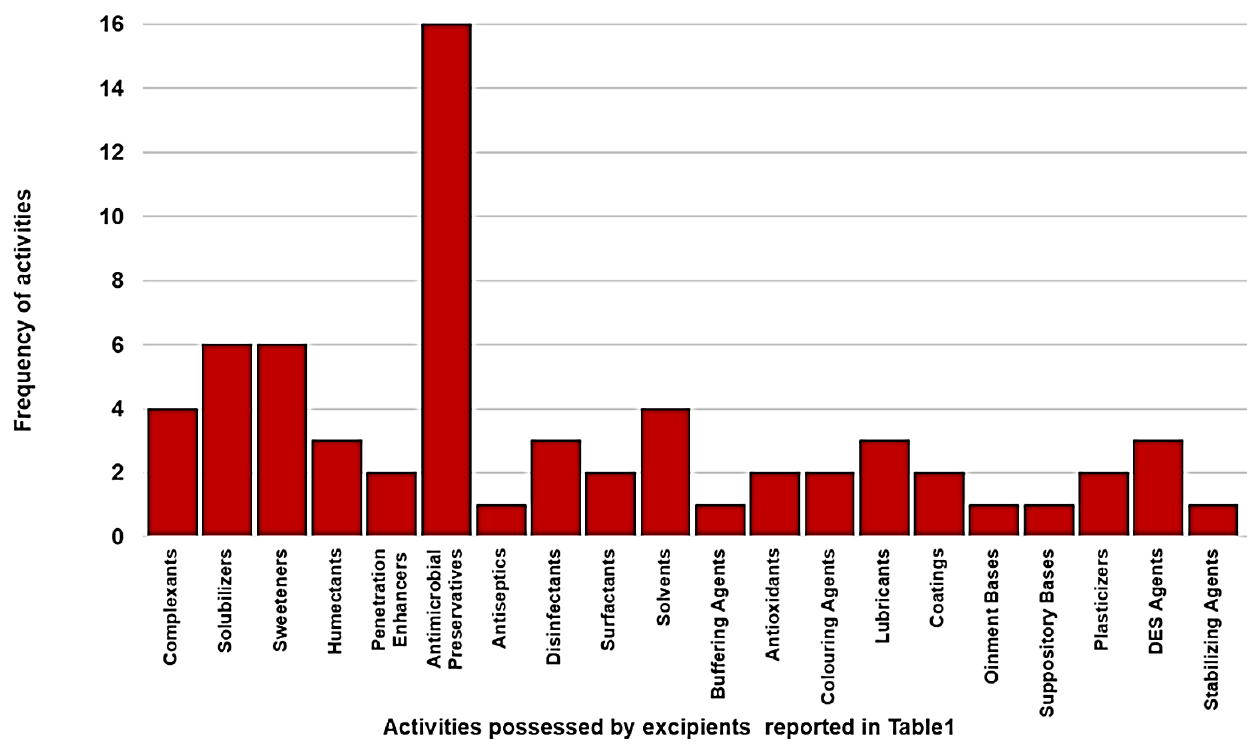
Figure 3. Main activities of excipients reported in Table 1 and their frequency (DES = dispersing, emulsifier, suspending). emulsifier,